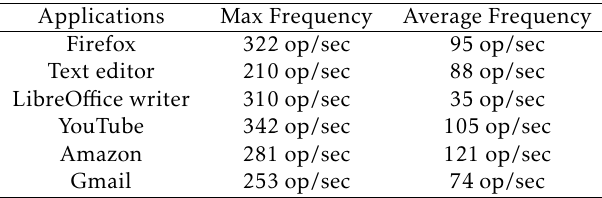
Table 4. Read/write frequency during normal